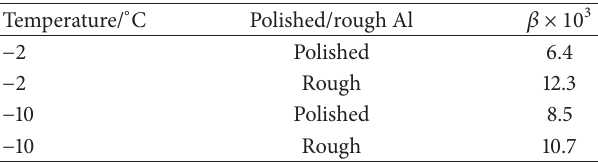
Figure 7: Friction as a function of hold time for experiments involv- ing rough aluminium, comparing − 2 ∘ C (+) and − 10 ∘ C (diamonds). A logarithmic line of best fit is fitted to the average results. The data compared here are also shown separately in Figures 4 and 5. Table1:Valuesof 𝛽 ,whichgivestherateofincreaseofstaticfriction, as a function of temperature and aluminium